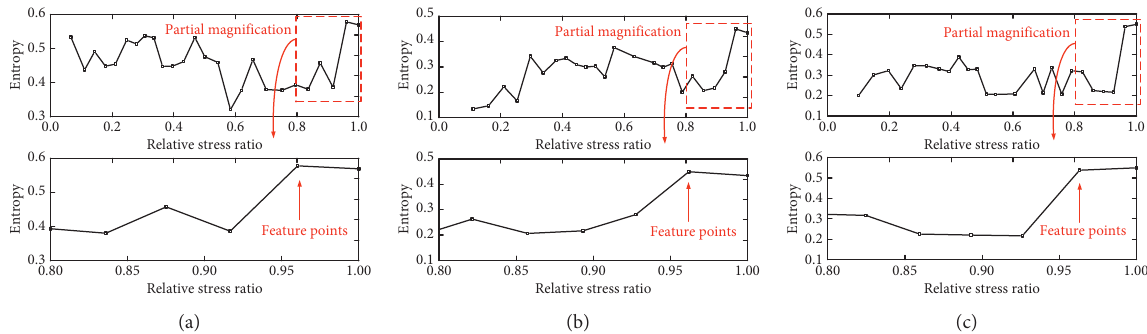
Figure 15: The variation rule of the acoustic emission entropy during the failure of weakly cemented sandstone under different dry-wet cycles. (a) N � 0. (b) N � 5. (c) N � 10.